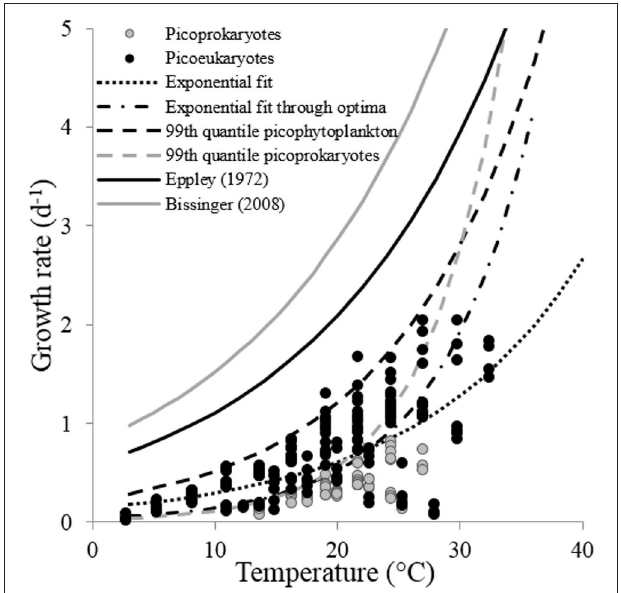
FIGURE 3 | The response of the maximum growth rates of a group of picophytoplankton to temperature. The lines indicate different fits discussed within this study: The exponential fit obtained from Equation (2) (exponential fit), the exponential fit through optimum growth rates at optimum temperatures of individual strains (exponential fit through optima), the exponential fit obtained from a 99th quantile regression to maximum growth rates of both, a group of picophytoplankton (99th quantile picophytoplankton), and a group of picoprokaryotes (99th quantile picoprokaryotes) and the fits presented in Eppley (1972) and Bissinger et al. (2008).